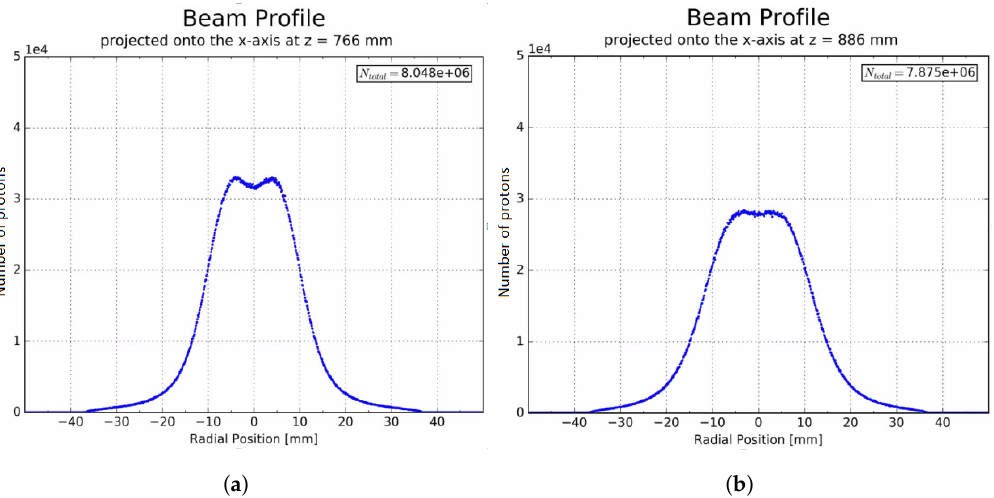
Figure 9. ( a ) Lateral profile of the proton beam at z = 766 mm; and ( b ) lateral profile of the proton beam at z = 886 mm. The profiles show a clear outward spread of protons from the core of the